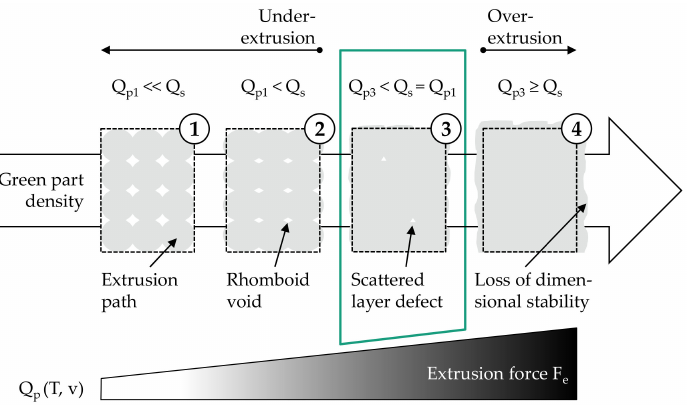
Figure 6. Schematic representation of the influence of the extrusion force on the green part density at a defined printing speed, extrusion temperature and flow rate of 100%.